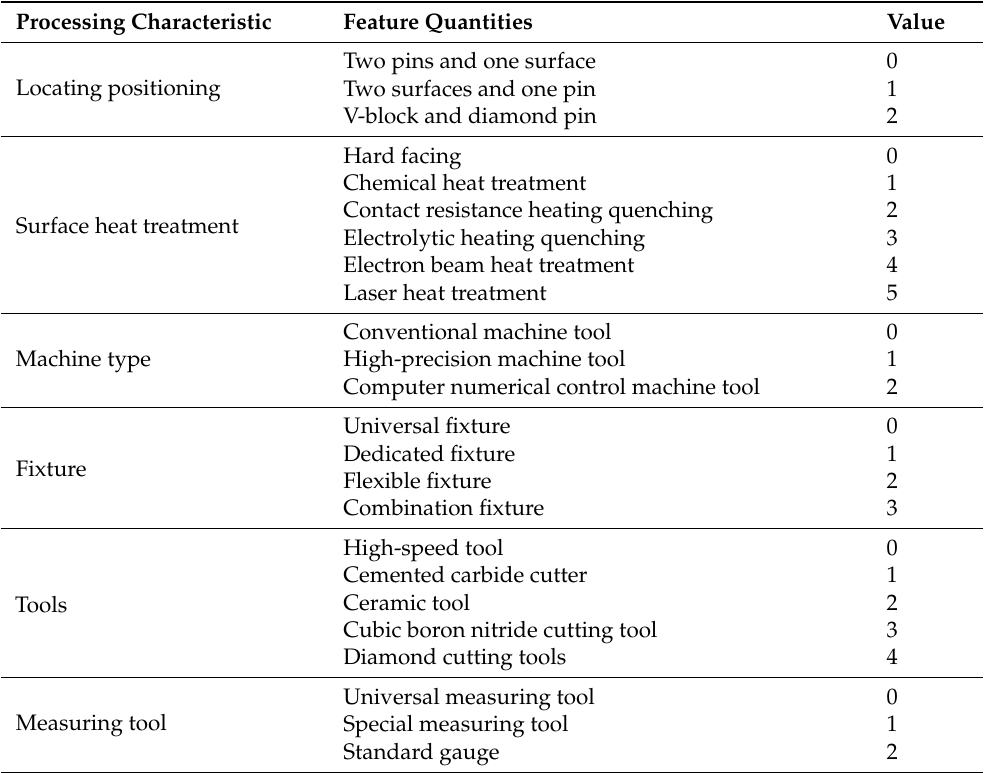
Table 4. Quantities corresponding to each machining